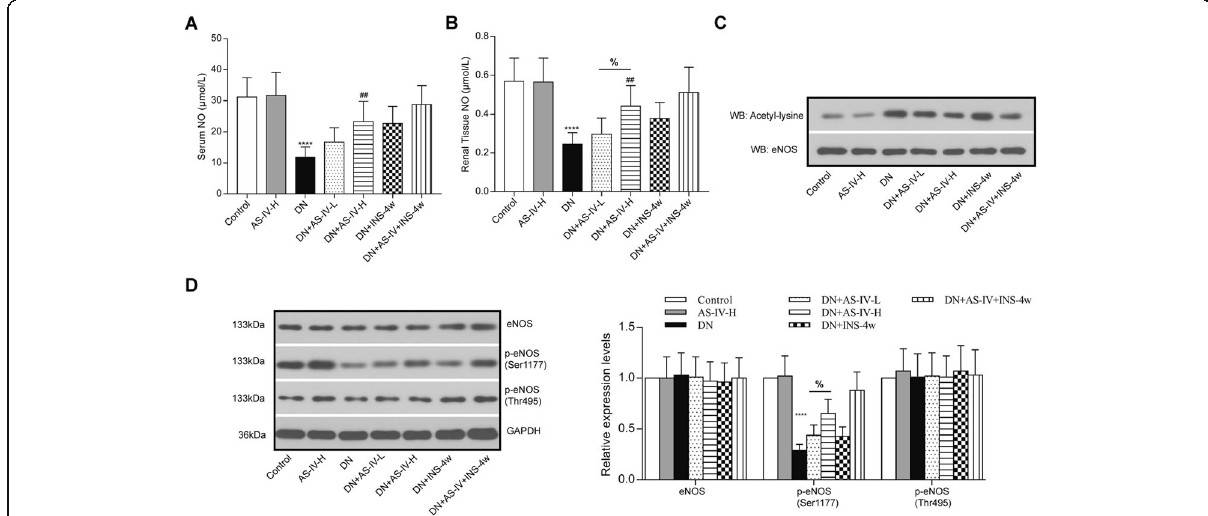
Fig. 3 AS-IV reversed high glucose-induced endothelial nitric oxide synthase (eNOS) Serum NO ( a ) and Renal Tissue NO ( b ) after AS-IV treatment in rats were detected by Nitric Oxide (NO) assay kit. n = 6 per group. Results are represented as mean and SD. c representative blot image of acetylated eNOS. d Western blot analysis for the expressions of eNOS, p-eNOS (Ser1177) and p-eNOS (Thr495). **** p < 0.0001 vs. control; ## p < 0.01 vs. DN. & p <